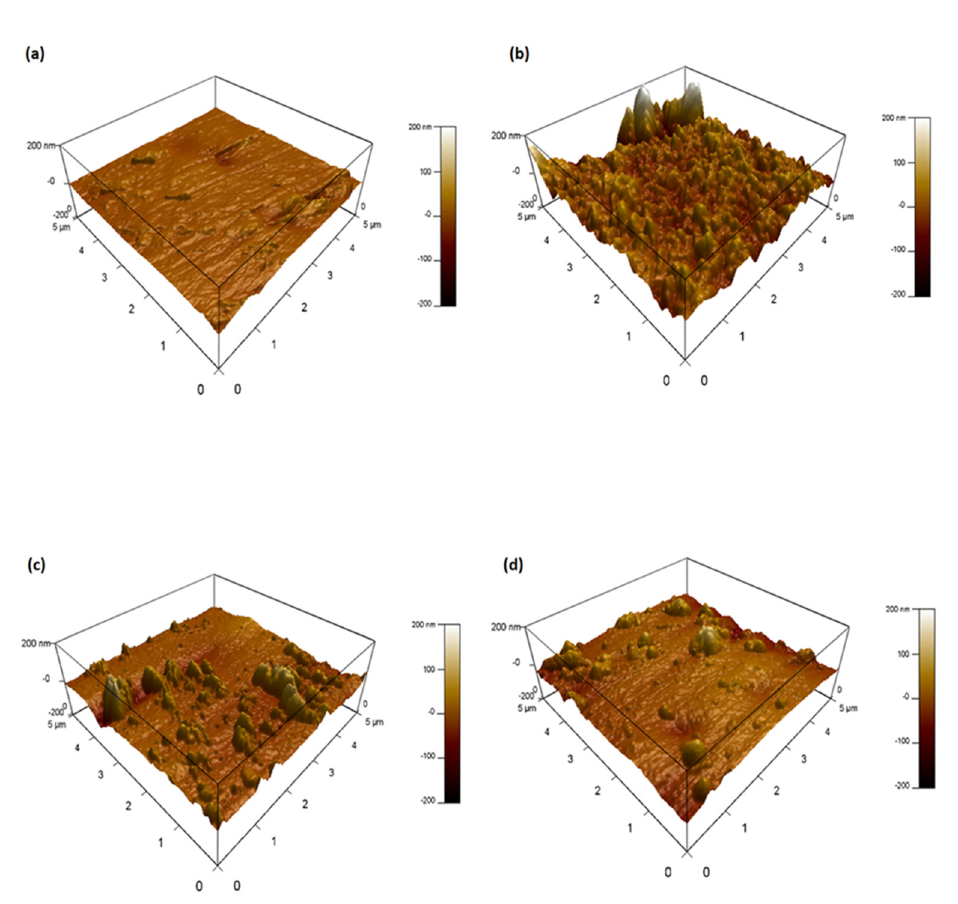
Figure 6. Atomic force microscopy (AFM) image of the active layer surface of CTA FO membrane after three consecutive FO runs: l ( a ) origin; ( b ) without physical cleaning; ( c ) in situ flushing; and ( d ) osmotic backwash. Conditions: FS = SWW, DS = MCFDS (300 g / L) and FS and DS flowrate = 1.6 LPM at room temperature for 24 h operating time.